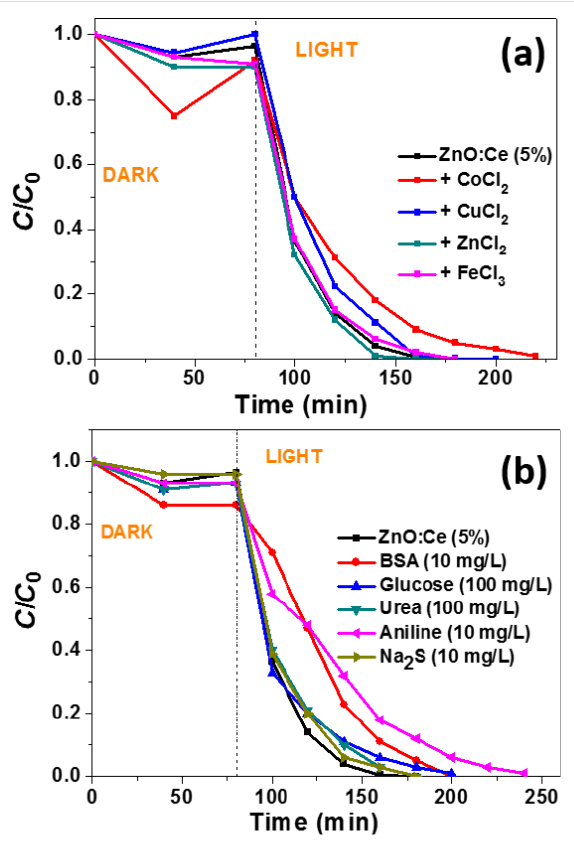
Figure 12: Effects of (a) transition metal salts and (b) of organic com- pounds and Na 2 S on the photocatalytic efficiency of the ZnO:Ce rods used under solar light irradiation (Volume of solution, 30 mL; Orange II concentration, 10 mg/L; mass of catalyst, 30 mg).